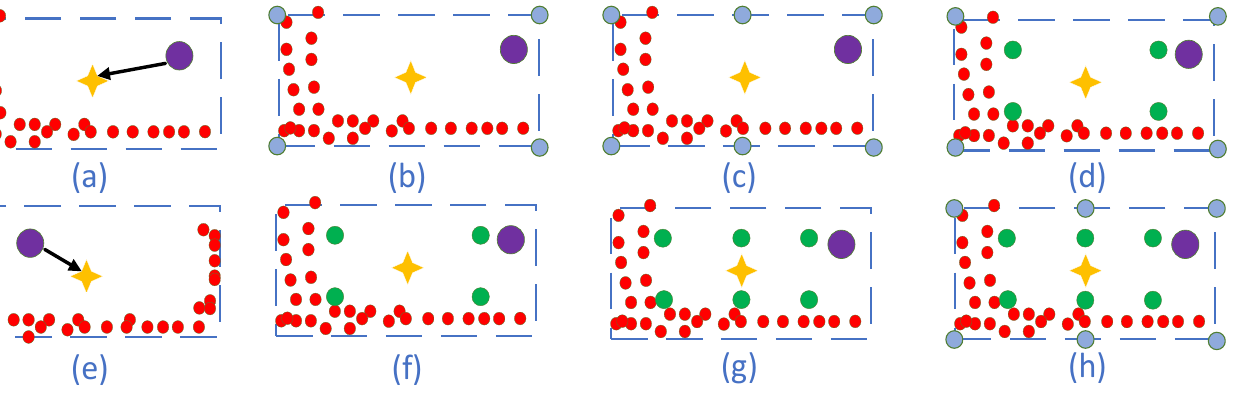
Figure 1. Various BEVs (bird’s eye views) of predicted bounding box. The purple circle refers to the predefined anchor point, which predicts the 3D bounding box. The blue circles refer to the extracted keypoints on the boundary, and the green circles refer to the extracted keypoints inside the bounding box. The blue dashed line refers to the BEV of the predicted bounding box. The red circles refer to the point on the detection object scanned by the LIDAR, the yellow star refers to the center location of the bounding box. ( a , e ) denote different relations of predefined anchor points and bounding boxes. ( b , c ) denote different distribution of boundary keypoints of the bounding boxes. ( f , g ) indicate different distribution of inner keypoints of the bounding boxes. ( d , h ) indicate different sampling methods covering the boundary and inner parts .